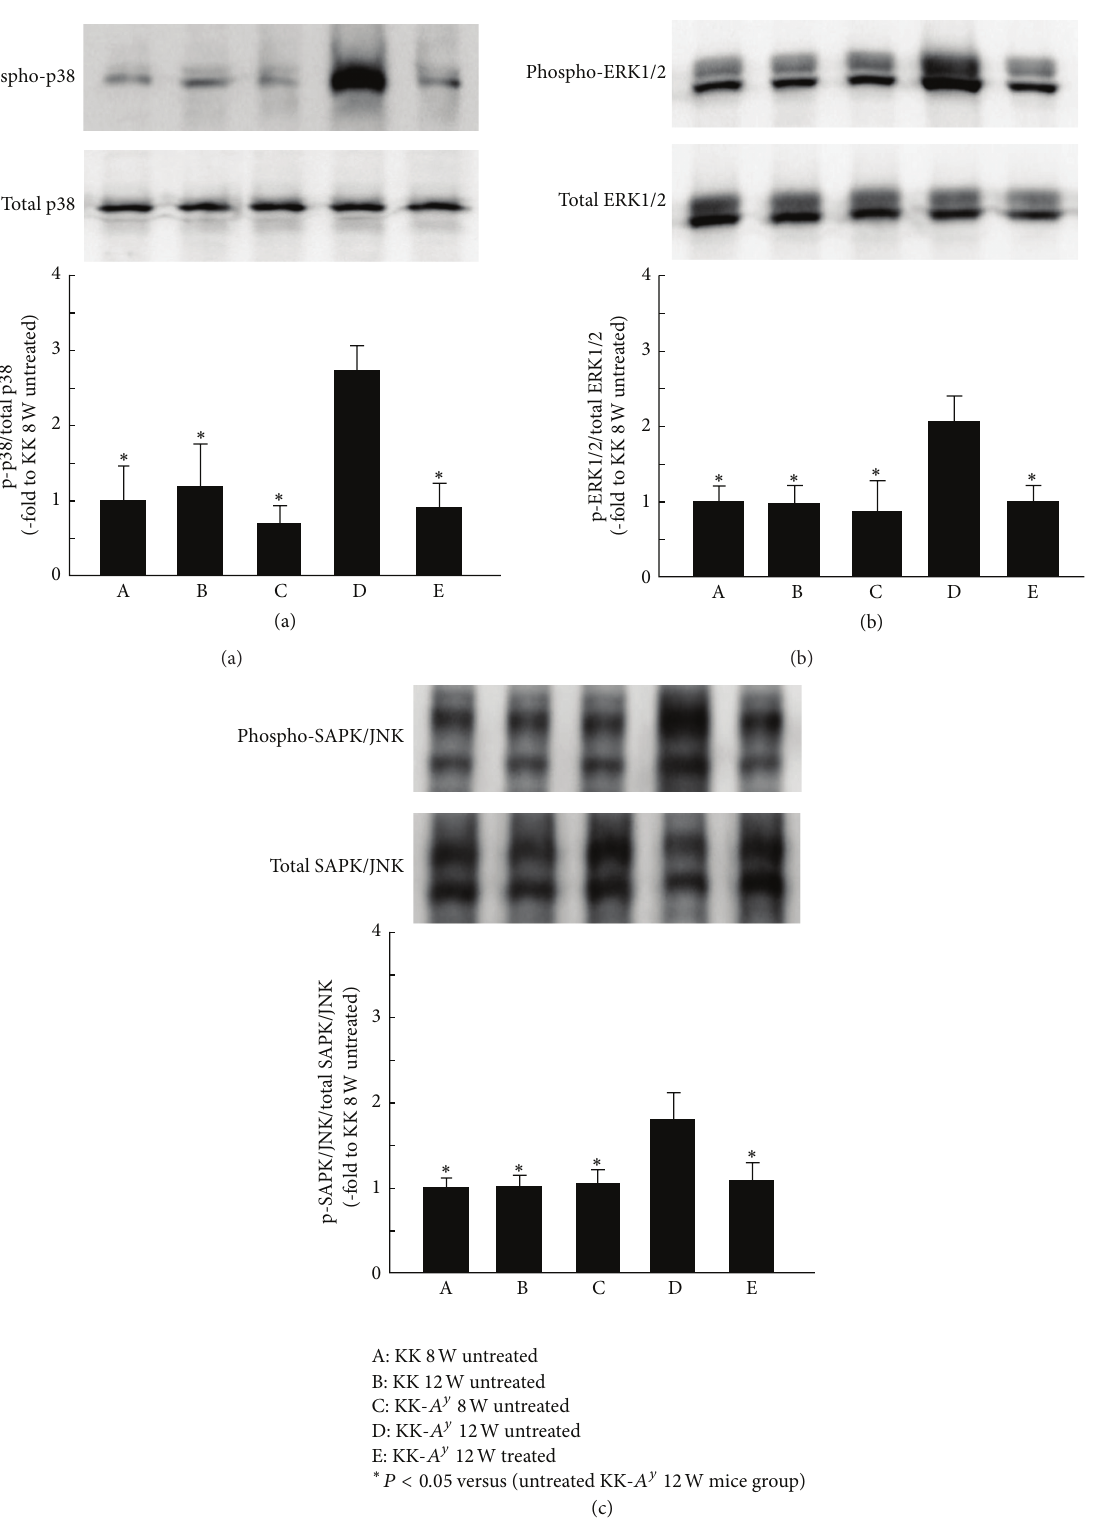
Figure 4: Mean protein levels of p-p38, p-ERK1/2, and p-SAPK/JNK in each mouse using Western blot analysis (A: untreated KK mice at 8 weeks of age, B: untreated KK mice at 12 weeks of age, C: untreated KK- 𝐴 𝑦 mice at 8 weeks of age, D: untreated KK- 𝐴 𝑦 mice at 12 weeks of age, and E: treated KK- 𝐴 𝑦 mice at 12 weeks of age). The expression of p-p38 (a), p-ERK1/2 (b), and p-SAPK/JNK (c) proteins is shown in the kidneys of mice from each group. These expressions were increased significantly in group 4 compared with groups 1, 2, and 3. This increase was attenuated in group 5 ( ∗ 𝑃 < 0.05 versus untreated KK- 𝐴 𝑦 mice at 12 weeks of